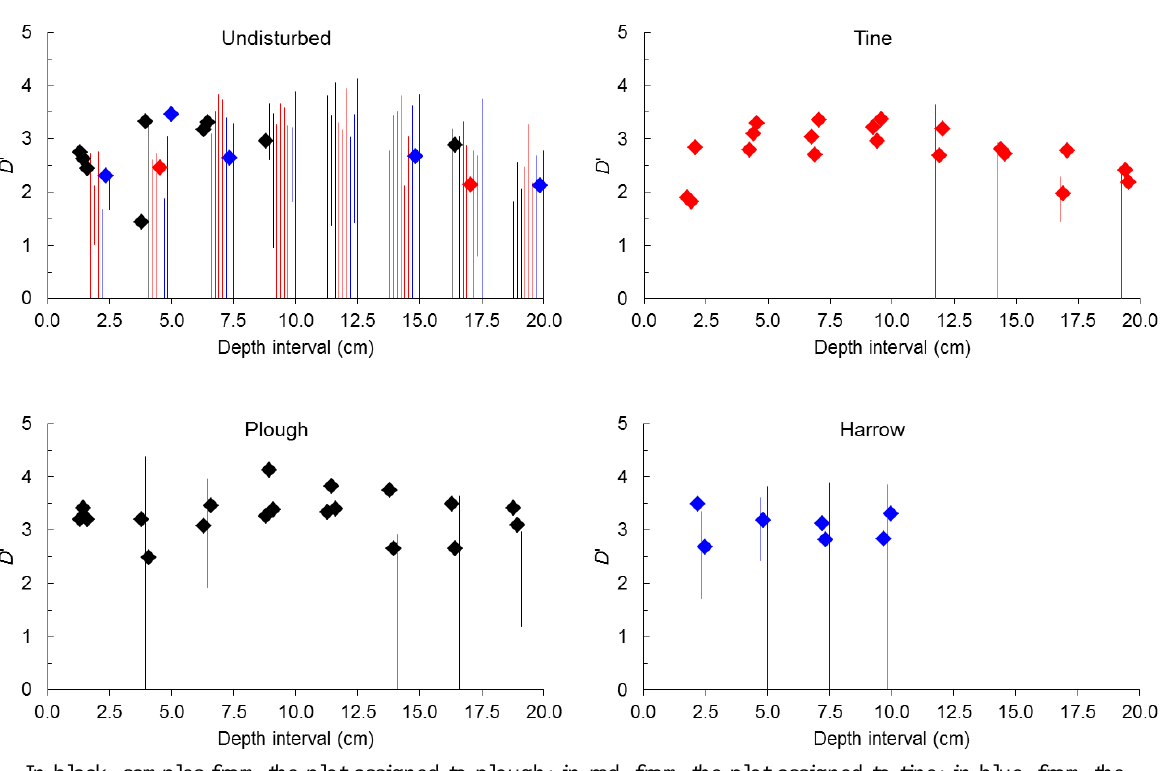
Figure 2. Value (points) or range (bars) of size-number distributions of seeds expressed by D ’ for all seeds (spherical plus non-spherical) before tillage (undisturbed) and after tine, harrow or plough at 2.5 cm depth